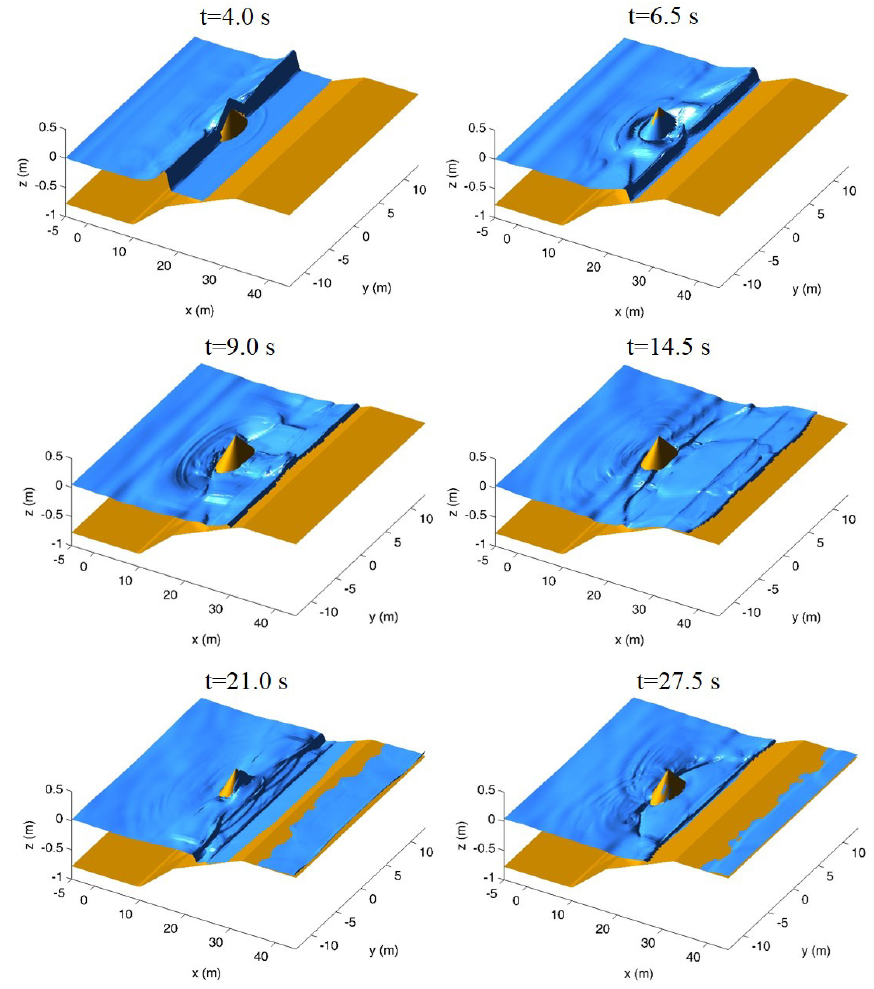
Figure 12. Case of Fig. 11. Surface elevations simulated at t = 4 . 0, 6.5, 9.0, 14.5, 21.0, and 27.5s in a nested-grid system.